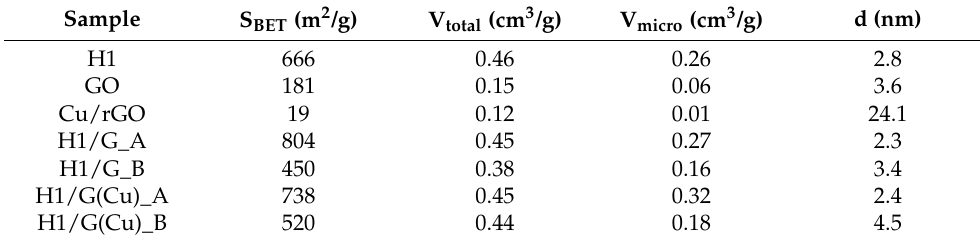
Table 4. Textural properties of HKUST-1, GO, Cu/rGO, and HKUST-1/GO composites. S BET — specific surface area, V total —total pore volume, V micro —micropores volume, and d—mean pore size.